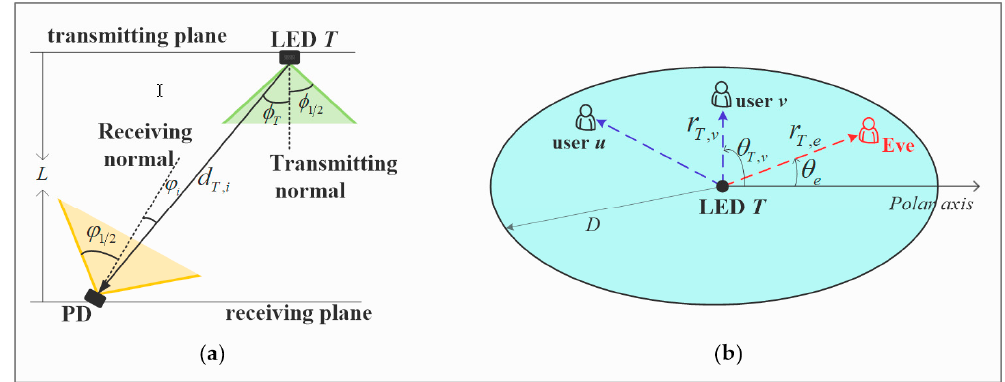
Figure 2. ( a ) Cross-section view of the intensity modulation direct detection (IM / DD) channel; ( b ) top view of the IM / DD